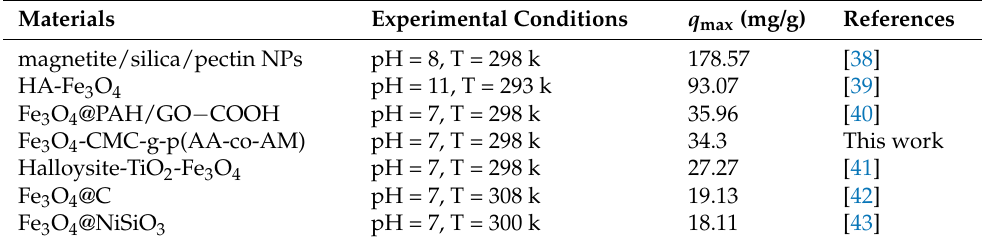
Table 2. Comparison of adsorption capacity of different adsorbents for the adsorption of MB.